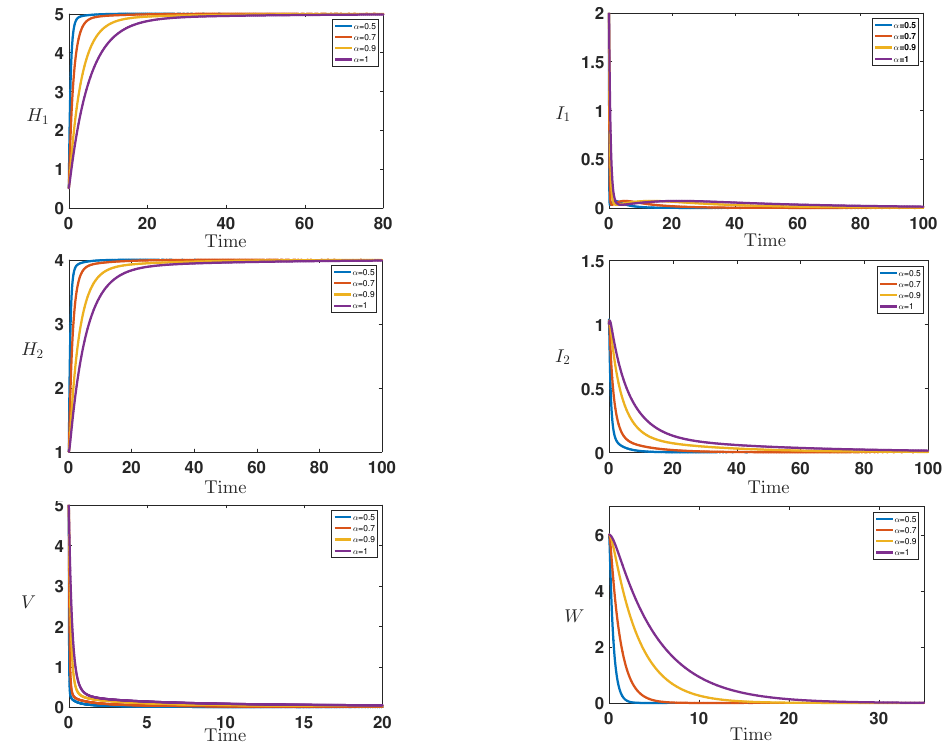
Figure 1. Behavior of the infection during the time for s 1 = 1, s 2 = 0.8, b 1 = 0.08, b 2 = 0.1, d 1 = 0.2, d 2 = 0.2, a 1 = 0.2, a 2 = 0.2, k 1 = 1, k 2 = 1.2, p = 0.3, r = 0.2, σ = 5 and q = 0.1, which correspond to the stability of the disease-free equilibrium E f = ( 5,0,4,0,0,0 ) with R 0 = 0.88 <